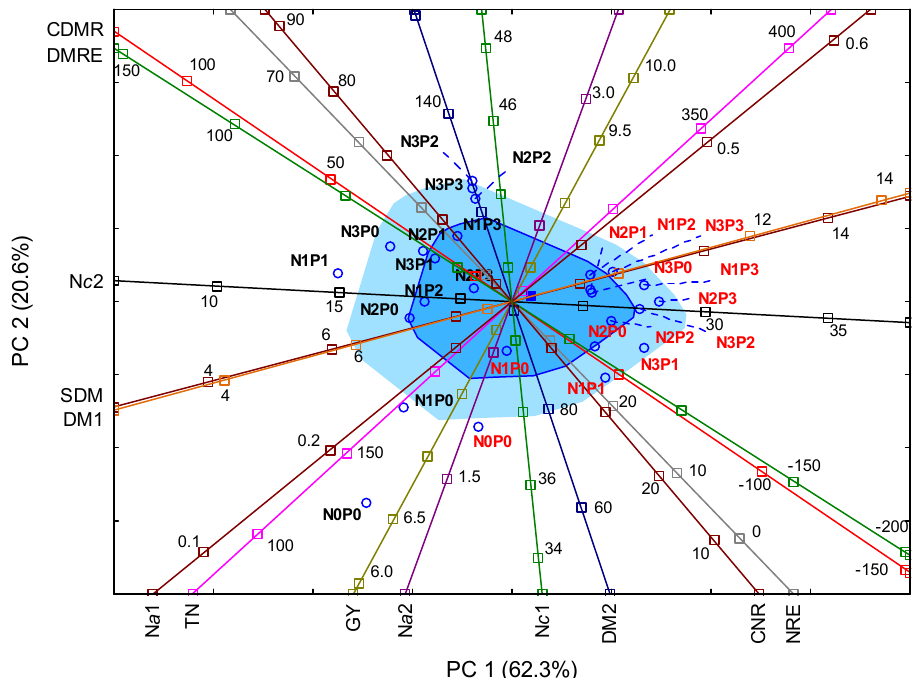
Figure 4. Principal component analysis (PCA) biplot of the maize yield, N content and accumulation, and N management indices. The dark blue square denotes the Tukey median, the blue square is the bagplot, the light blue square is the bagplot cover. Key: GY—grain yield; SDM—crop residues (straw) biomass; TN—total N accumulation; DM1—dry matter of plant at seventh leaf growth stage; N c 1—N concentration at seventh leaf growth stage; N a 1—N accumulation at seventh leaf growth stage; DM2—dry matter of plant at flowering; N c 2—N concentration at flowering; N a 1—N accumulation at flowering; DMRE—dry matter remobilization efficiency; CDMR—contribution of DMR assimilates to grain; NRE—N remobilization efficiency; CNR—contribution of remobilized N to grain N content. The treatments in 2019 are marked in red and the treatments in 2020 in